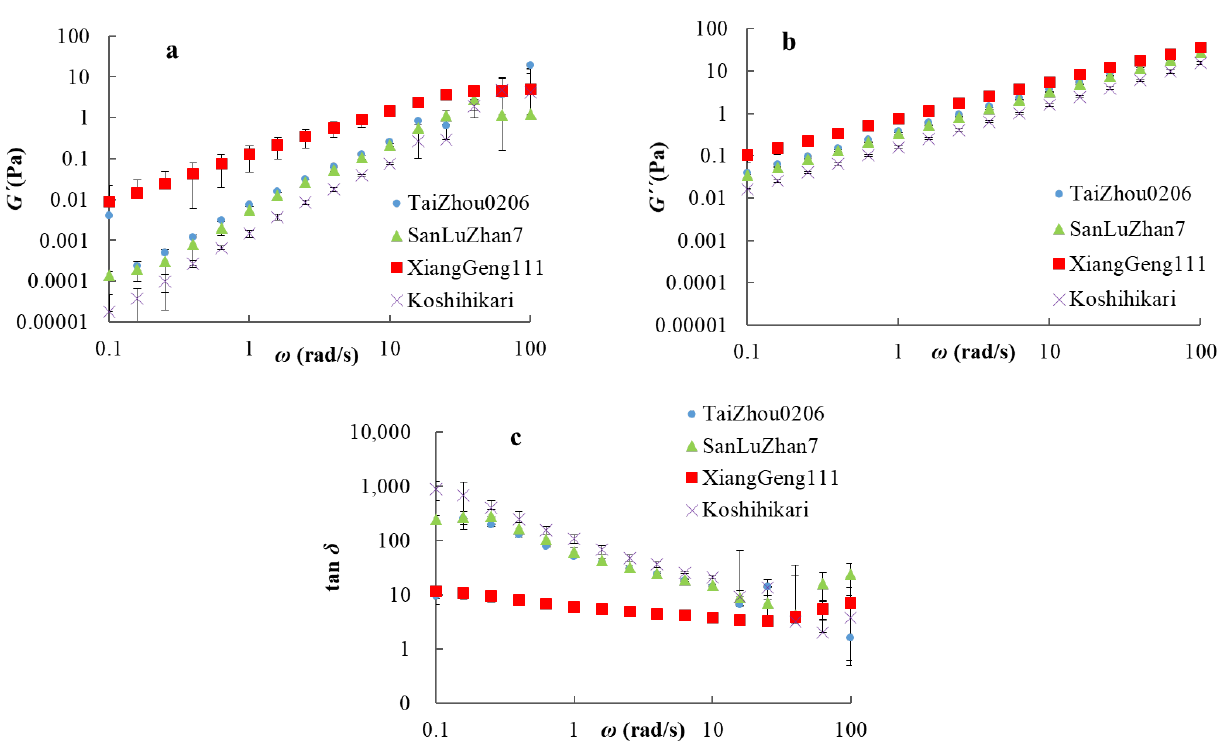
Figure 3. Dynamic viscoelasticity as a function of frequency, ω, for amylose solutions: ( a ): dynamic storage moduli ( G′ ); ( b ): dynamic loss moduli ( G ″); ( c ): loss tangent (tan δ). In order to quantify the differences among those samples, the power-law model was applied to fit the dynamic viscoelasticity data of the mechanical spectra (R 2 > 0.99). The parameters obtained for log K (cid:48) , log K (cid:48)(cid:48) , n (cid:48) , and n (cid:48)(cid:48) are listed in Table 3. In comparison with